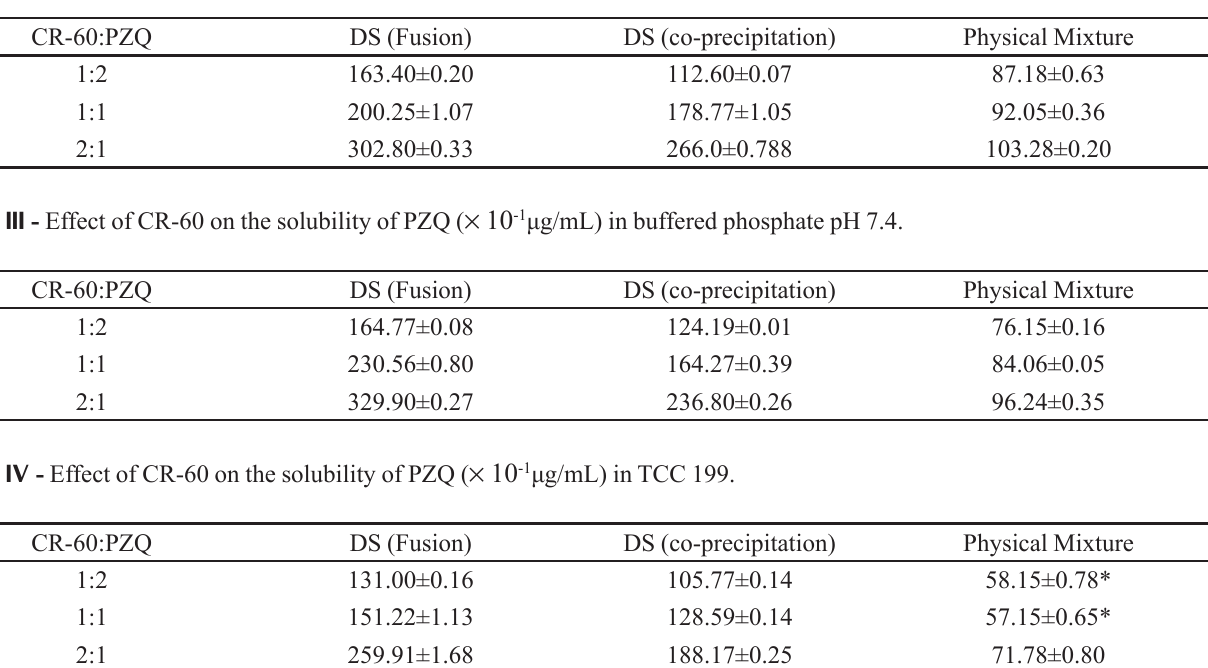
TABLE II - Effect of CR-60 on the solubility of PZQ ( × 10 -1 μg/mL) in HCl 01N.